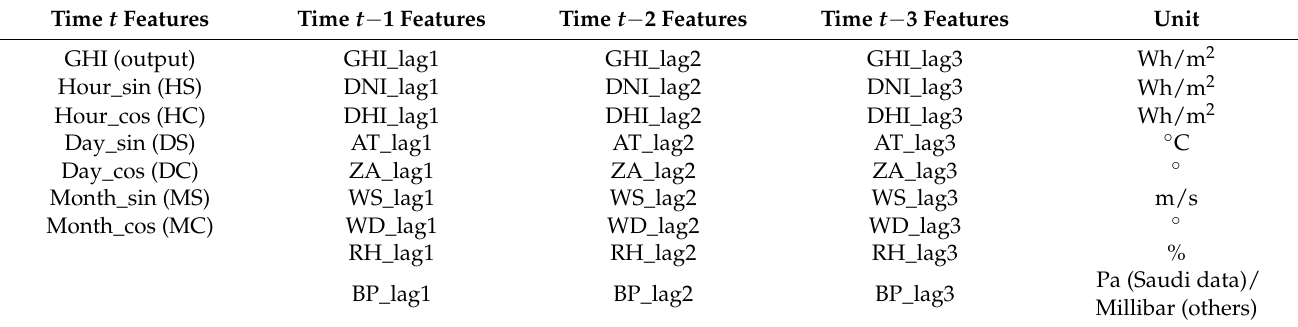
Table 4. Forecasting datasets features.